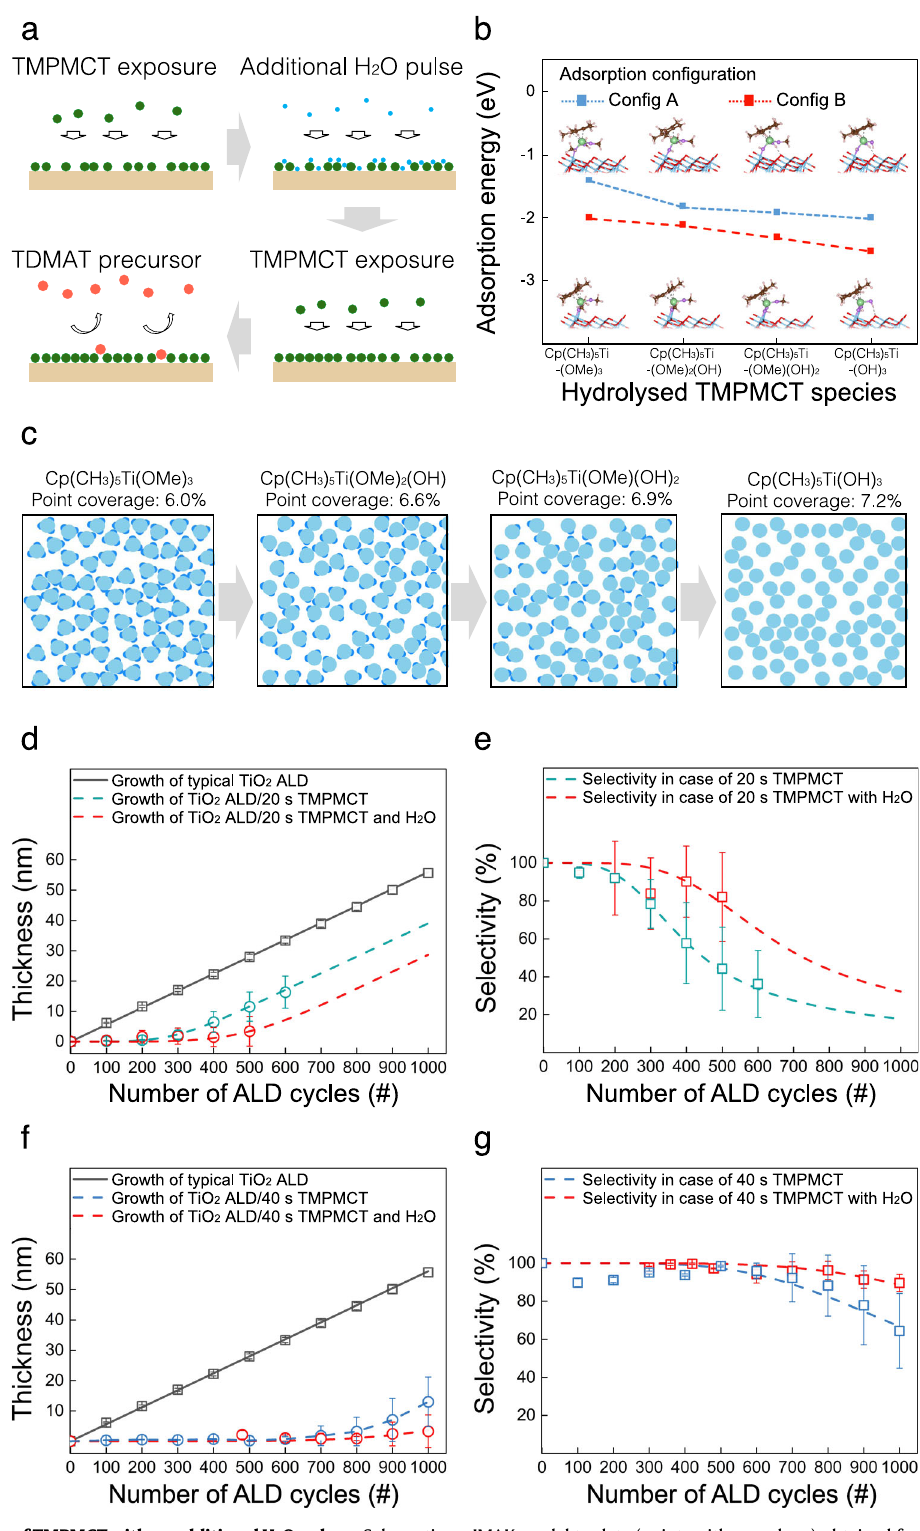
JMAK model to data (points with error bars) obtained from d growth and e selectivity in the case of 20s TMPMCT with and without additional H 2 O pulse samples. Fitting of the JMAK model to data (points with error bars) obtained from f growth and g selectivity in the case of 40s TMPMCT with and without additional H 2 O pulse samples. Source data are provided as a Source data fi